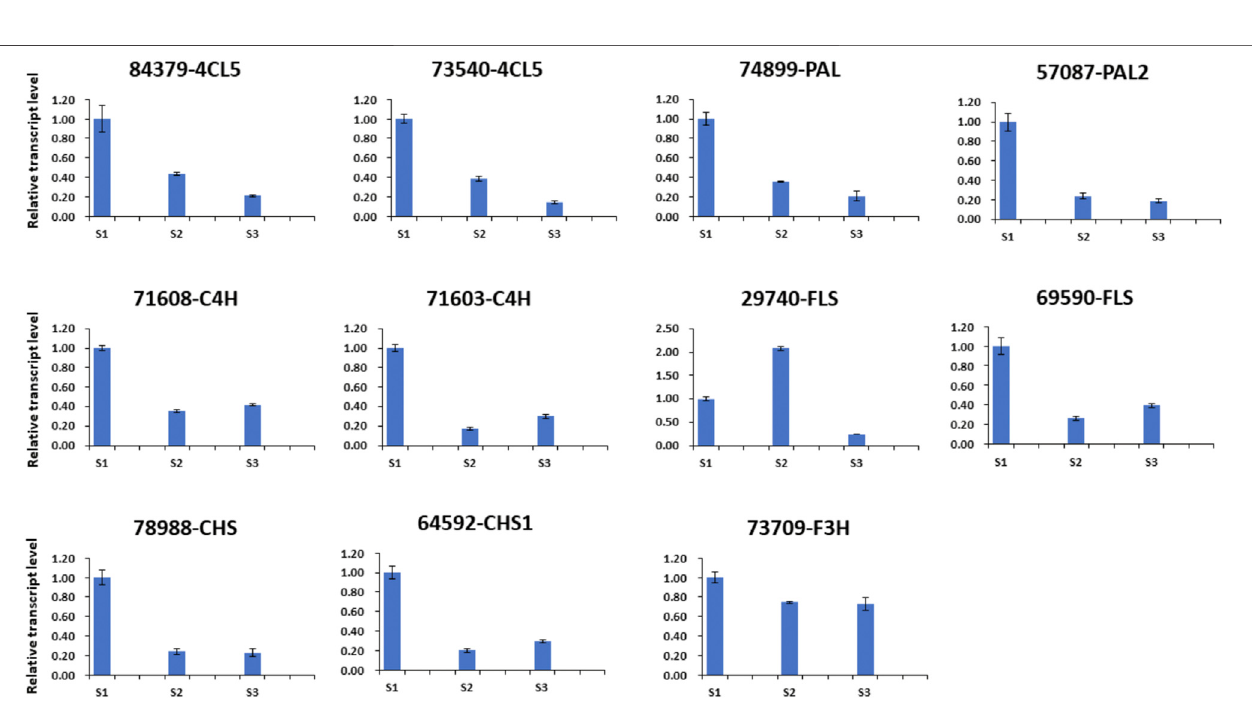
FIGURE 8 | The qRT-PCR of polyphenol compounds related genes at three developmental stages of nutshell.